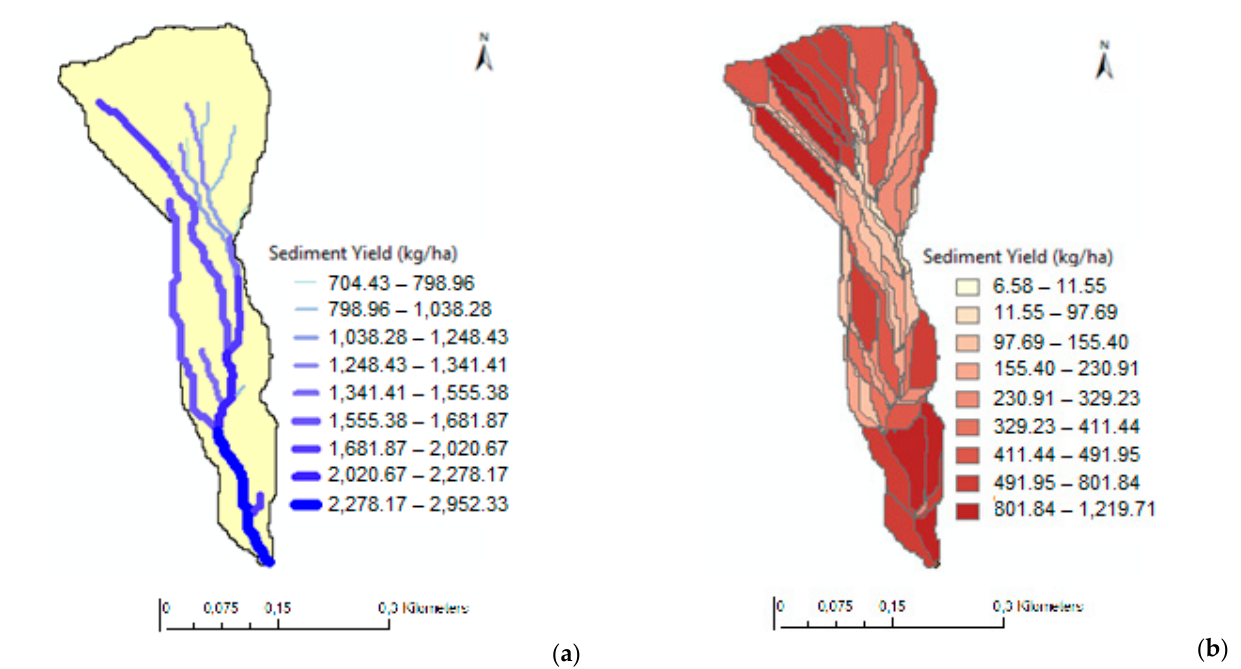
Figure 6. Graphical representation of eroded solid material from KINEROS 2 (in kg/ha) for Event 1: ( a ) sediment produced in kg/ha at streams, ( b ) sediment produced in kg/ha at Aviar Basin [3].